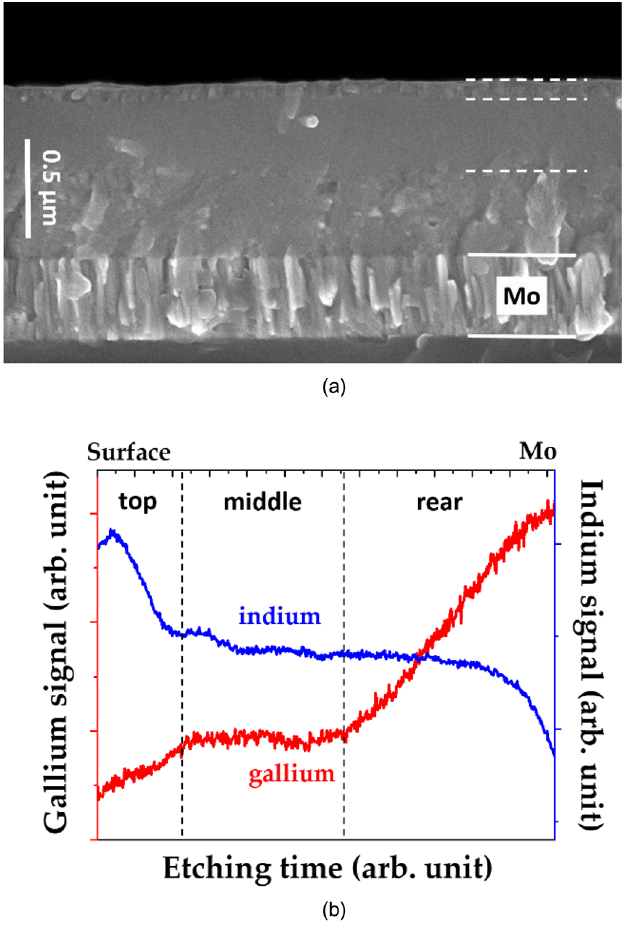
Fig. 2. (a)Scanningelectronmicroscopeimageofthecrosssection of the fi lm at the end of the fi rst stage. This image shows the morphological layered structure of the fi lm at the end of the fi rst stage. (b) Qualitative pro fi les of gallium (in red) and indium (in blue) measured by glow discharge optical emission spectrometry throughout a fi lm at the endof the fi rst stage. This plot shows three different zones corresponding to the layers observed by SEM.